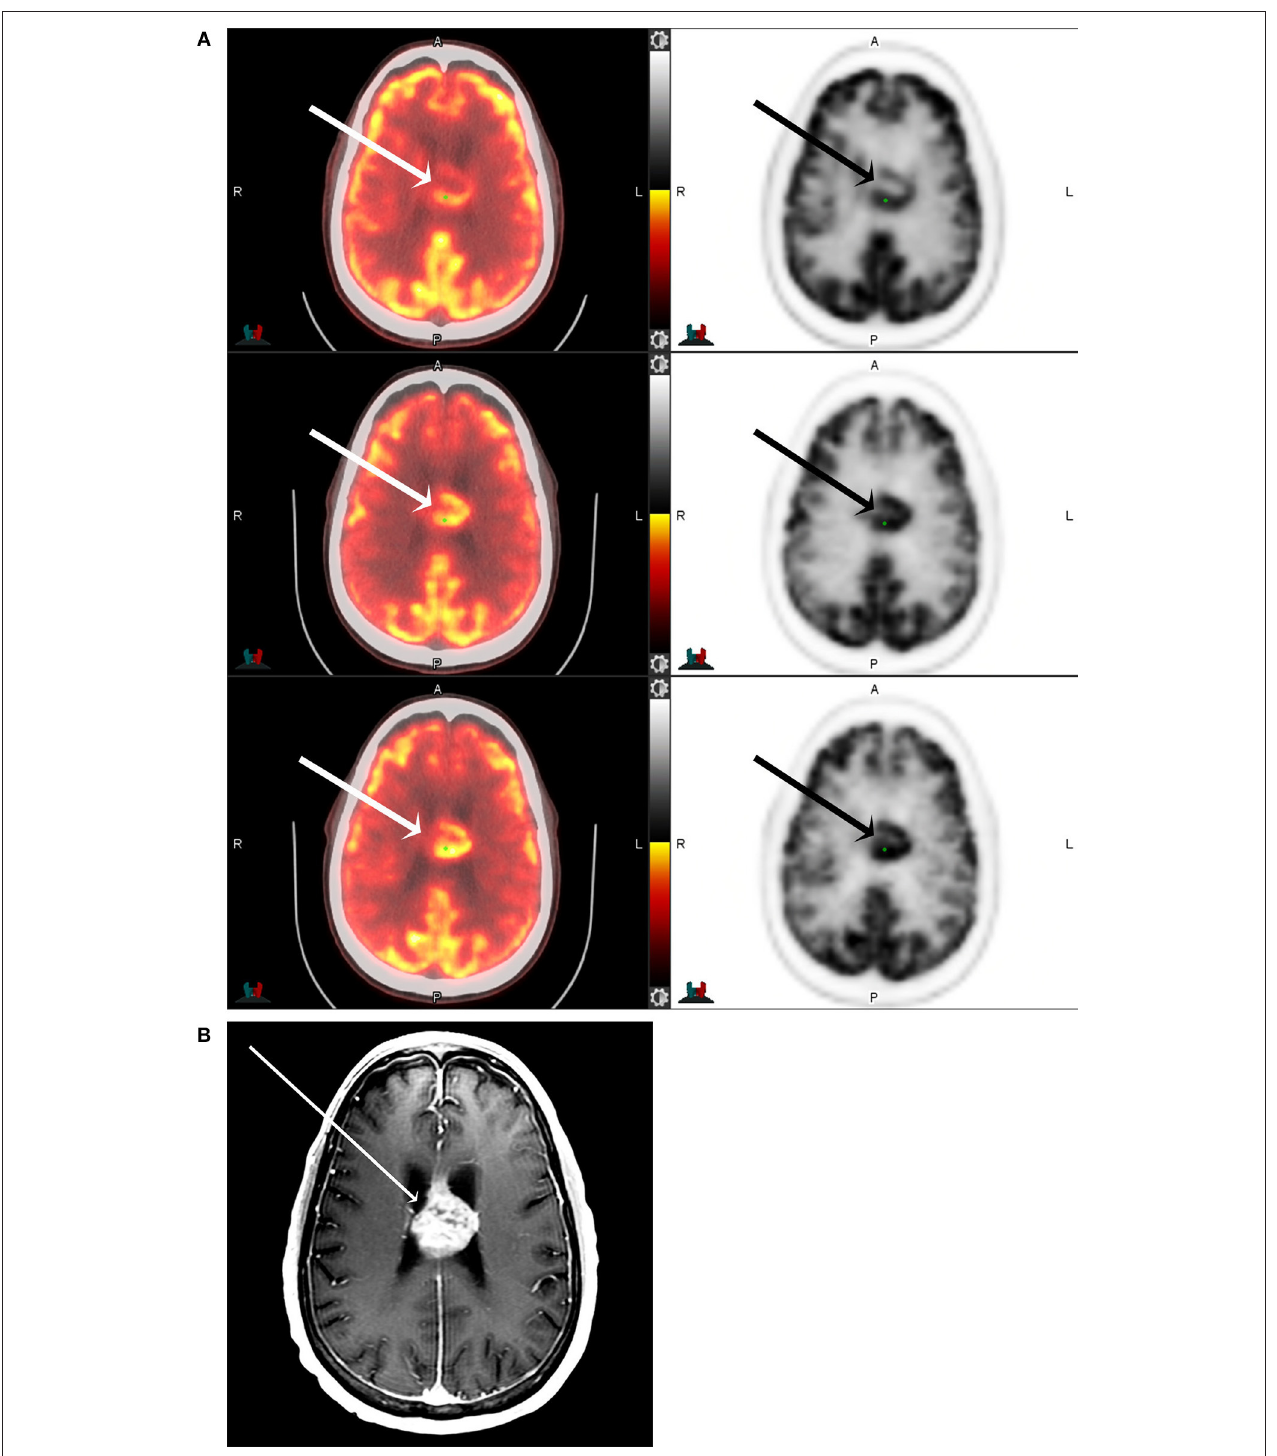
FIGURE 3 | F18 FDG PET CT (A) and T1 postcontrast MRI of the brain (B) of a 71-year-old male with IDH-mutant, glioblastoma involving the corpus callosum and cingulate gyrus (arrows) at 1-, 5-, and 8-h following F18-FDG injection. The maximum tumor SUV, as well as the tumor to background ratios, are seen to increase with increasing time from the